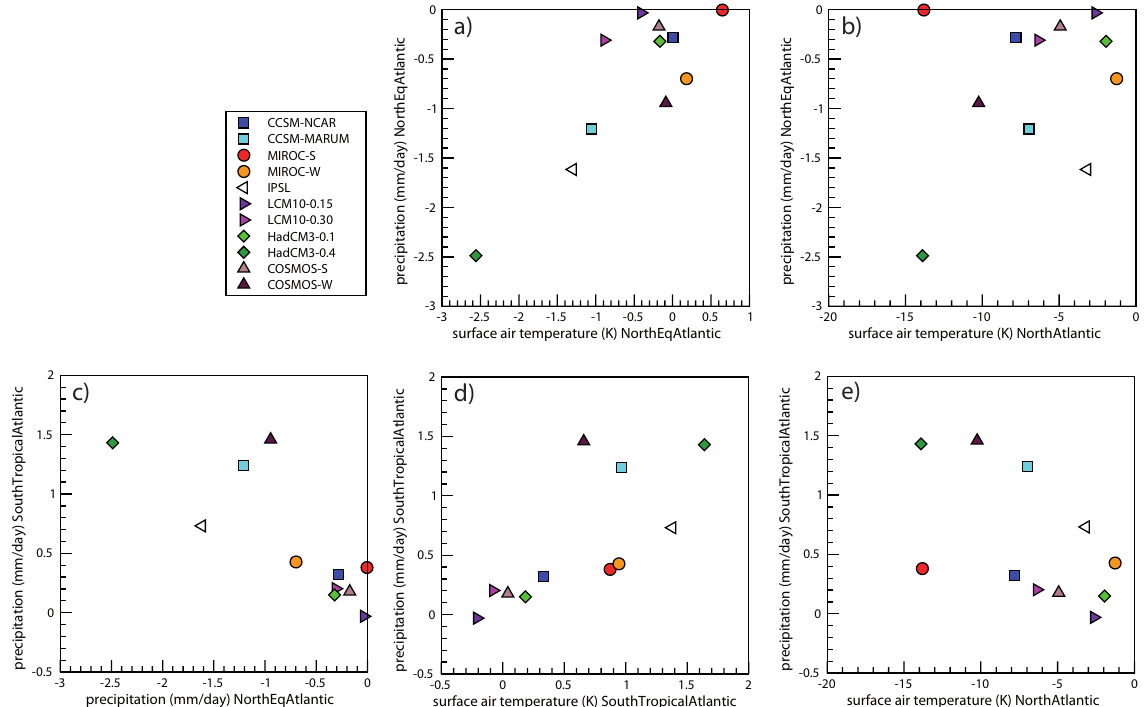
Fig. 8. Relationships involving tropical Atlantic precipitation changes related to fresh water hosing: (a) between the precipitation and tem- perature changes over the NorthEqAtlantic region, defined as the region with latitudes ranging between 5 and 15 ◦ N and longitudes between 50 and 15 ◦ W; (b) between the NorthEqAtlantic precipitation changes and the NorthAtlantic (as defined in Fig. 6) temperature changes, (c) between the precipitation changes over the SouthTropicalAtlantic and the NorthEqAtlantic region, (d) between the precipitation and temper- ature changes over the SouthTropicalAtlantic region defined as in Fig. 7, (e) between the SouthTropicalAtlantic precipitation changes and the NorthAtlantic emperature